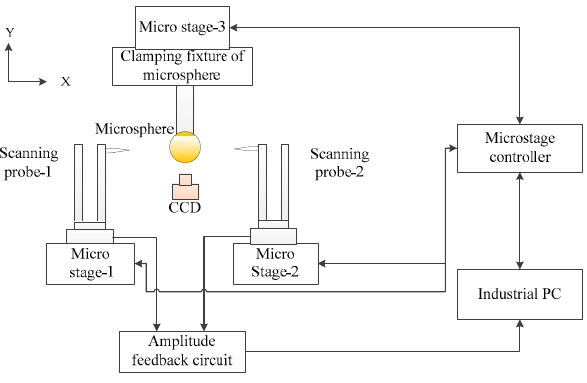
Figure 1. Diagram of the measurement system.